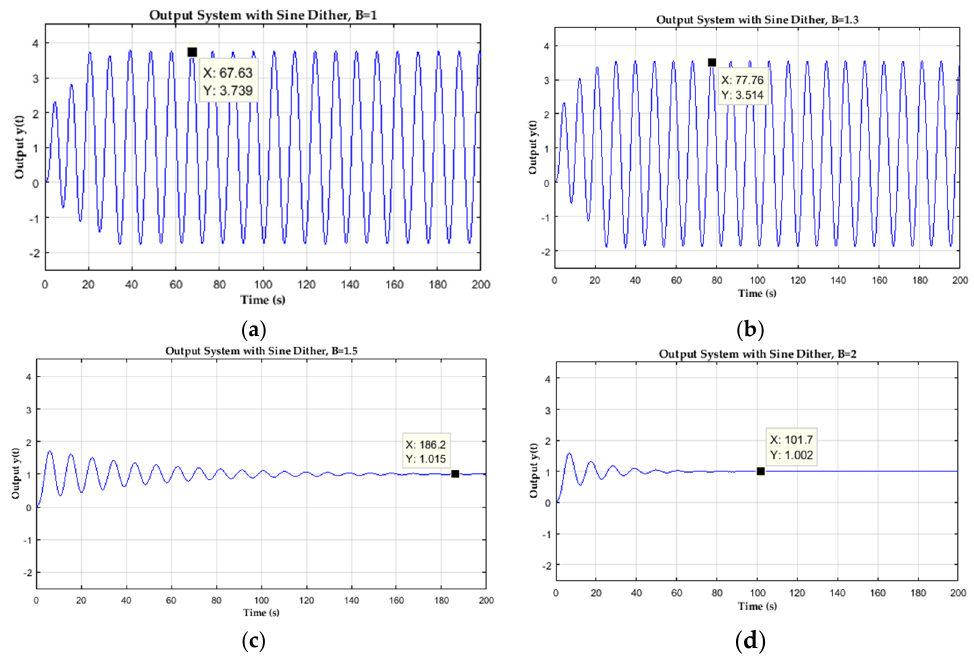
Figure 7. Closed-loop step response with Sine wave dither injection, ( a ) with dither amplitude B = 1, ( b ) B = 1.3, ( c ) B = 1.5, and ( d ) B = 2.